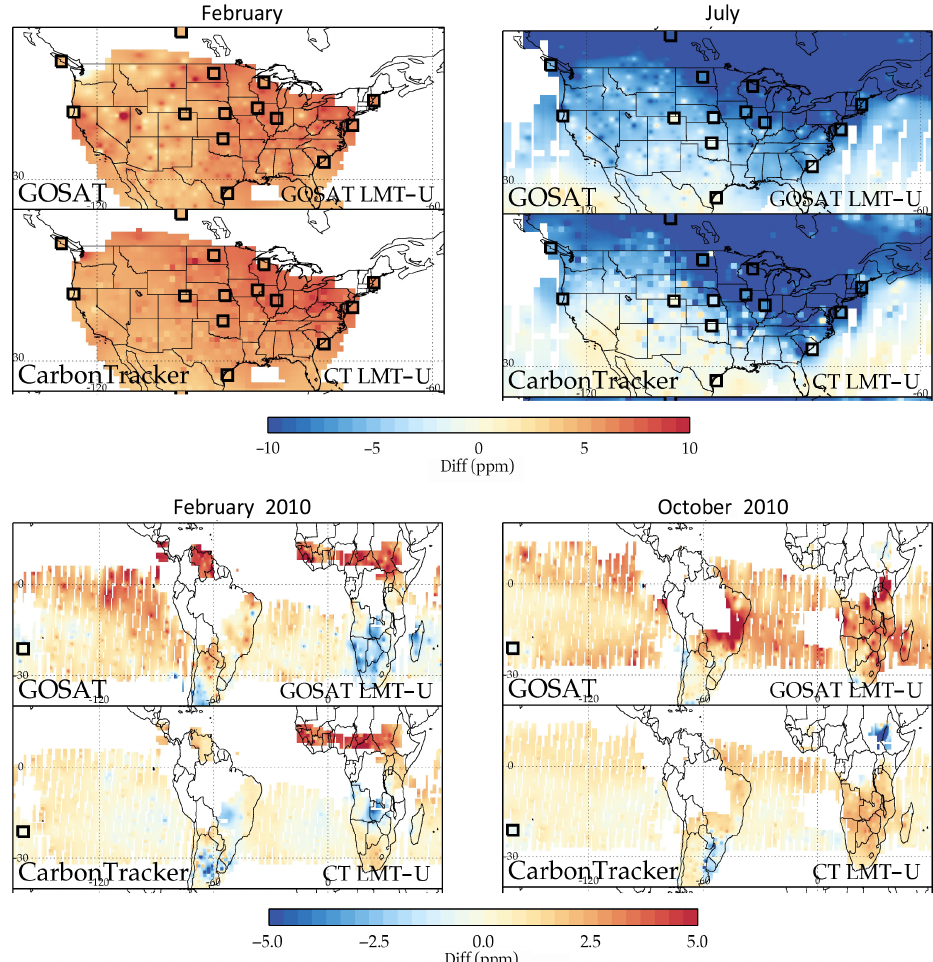
Figure 12. LMT – U differences. Results shown for the US (top) and South America and Africa (bottom) for 2 different months, with GOSAT on the top and CarbonTracker on the bottom. Aircraft LMT – U differences are shown in the squares. There is agreement in the US, except for the southwestern US in July, with more differences in the Southern